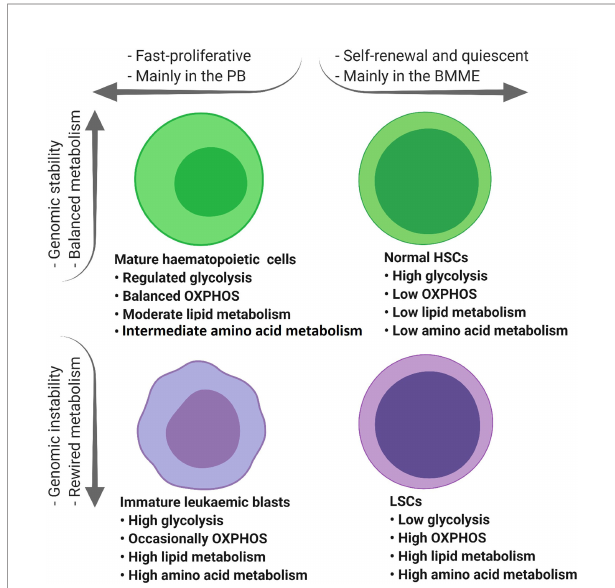
FIGURE 3 | The tumour microenvironment alters the metabolic pro fi le of different types of haematopoietic cells. Mature haematopoietic cells and normal HSCs maintain their genome integrity and therefore regulate their metabolic pro fi le in a balanced manner (green cells). In contrast, immature leukaemic blasts and LSCs with an unstable genome display dysregulated metabolic pro fi les (purple cells). PB, peripheral blood; BMME, bone marrow microenvironment; OXPHOS, oxidative phosphorylation; TCA, tricarboxylic acid cycle; ETC, electron transfer chain; HSCs, haematopoietic stem cells; FAO, fatty acid oxidation; AAs, amino acids; LSCs, leukaemic stem